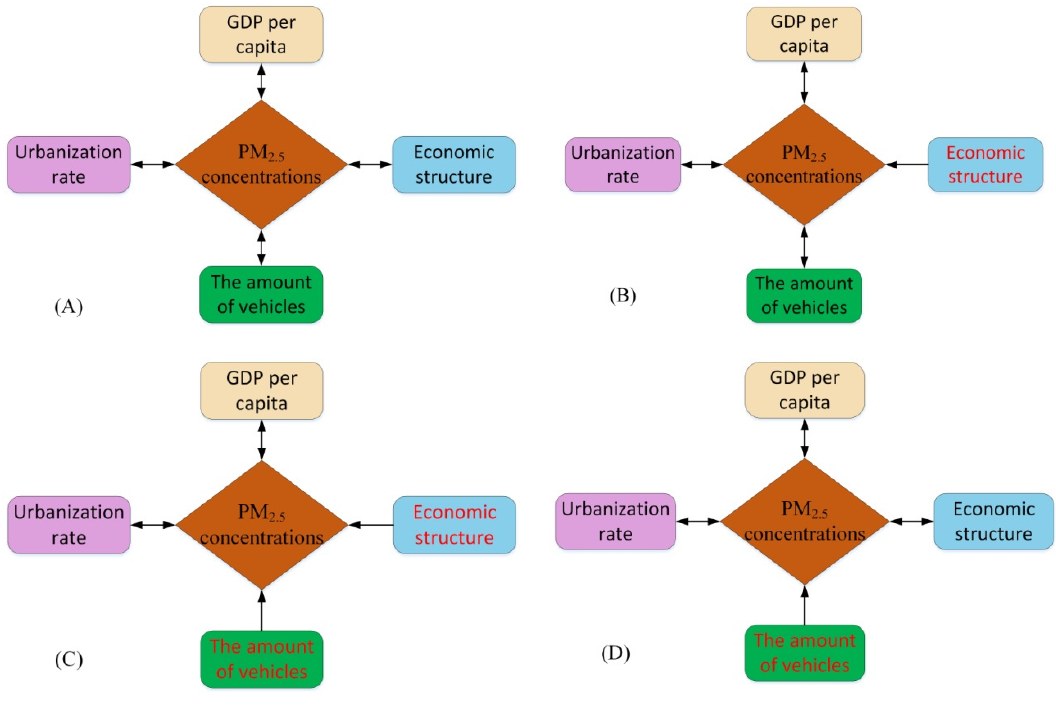
Figure 2. Granger causal nexus among all variables for the 31 provinces. ( B ) Beijing, Tianjin, and Shanghai, ( C ) Hainan and Tibet, ( D ) Qinghai and Ningxia, and ( A ) for the rest of the 31 provinces.